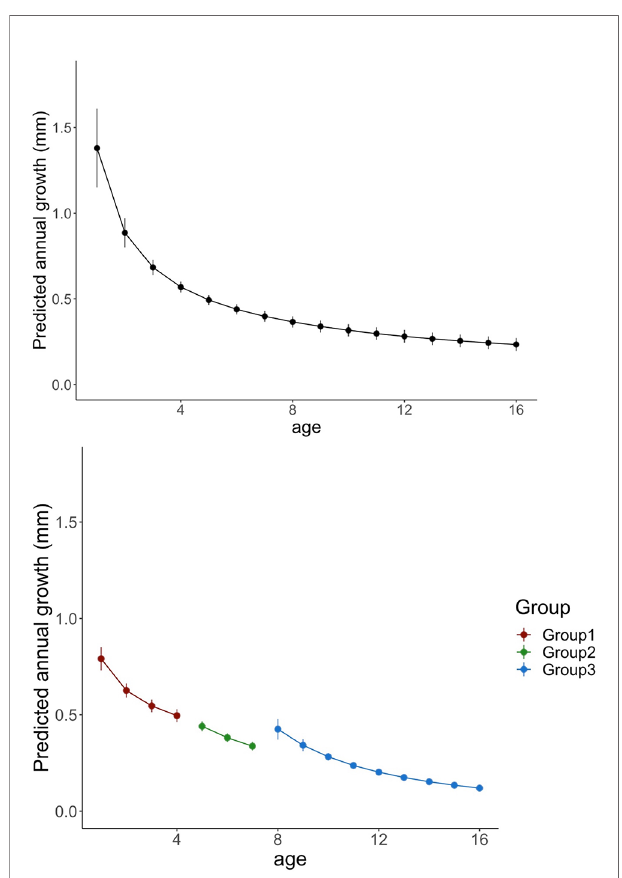
FIGURE 5 | Predicted variations in annual growth of cod for all age groups (left panel) and for each age group (right panel). Line colors indicates age groups (All groups: black; group 1: red; Group 2: green and Group 3 blue). Vertical lines denotes standard